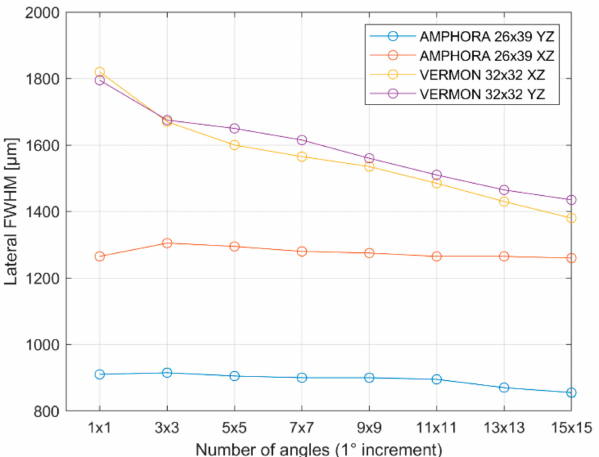
Figure 14. Full-width half maximum of the PSF evaluated for both transducers in both directions as a function of the number of compounding angles.